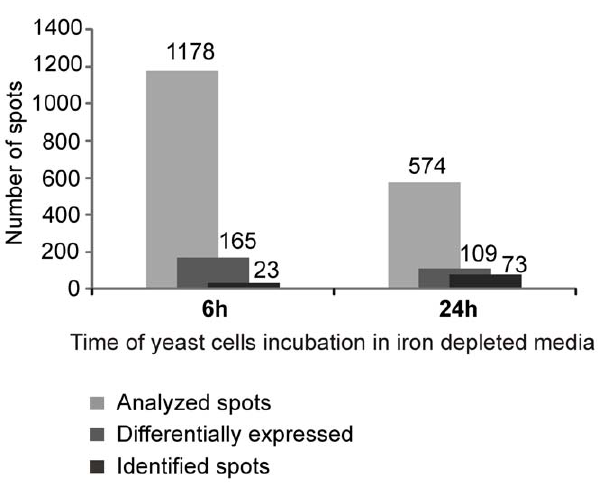
Figure 3. Graphic summation of P.brasiliensis iron restriction proteomic analysis. Number of spots differentially expressed were determined using 2D-gel image analysis software. Statistical analysis of the matched spots were performed using